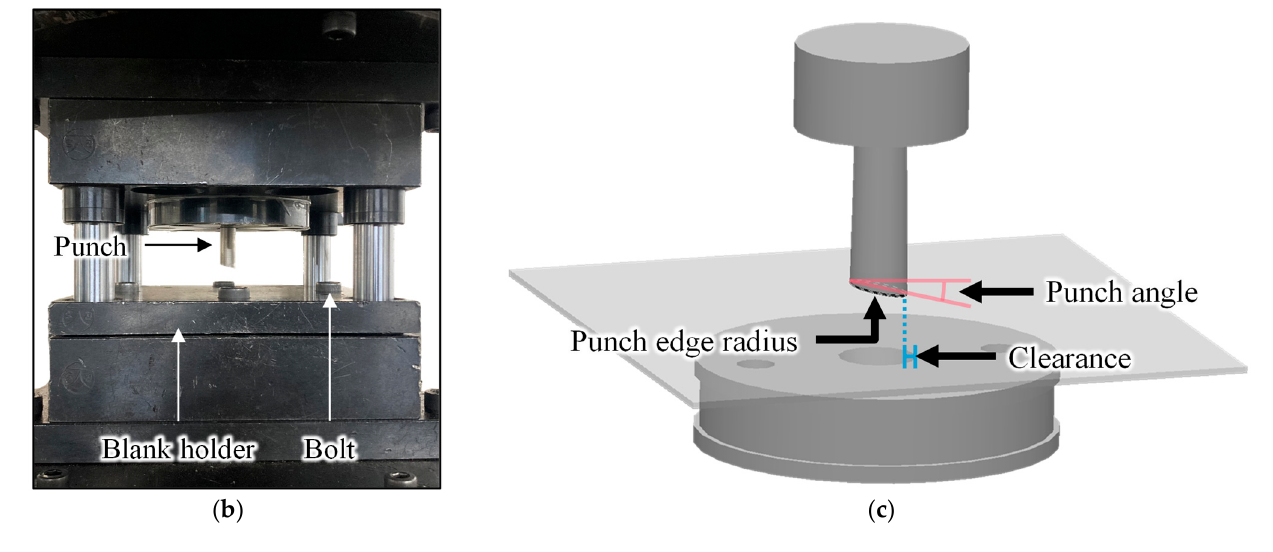
Figure 3. Experimental set-up for punching process: ( a ) die set, ( b ) punching set-up for the experi- ment, and ( c ) process parameters in punch and die. Table 2. Result of tensile test for DP780, DP980, and MART1500.